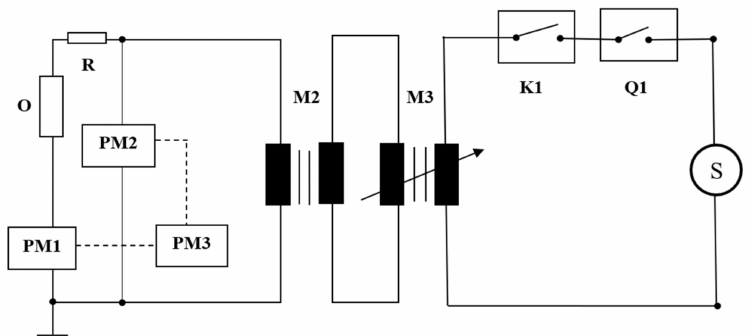
Figure 4. Circuit used to determine the time–current characteristic where: S—source; Q1—single- phase circuit breaker 400 V/1000 A; K1—protection circuit breaker 400 V/1250 A; M2, M3— autotransformer 70 kVA; R—variable power resistance PM1—current transformer 2 × 50/5A and